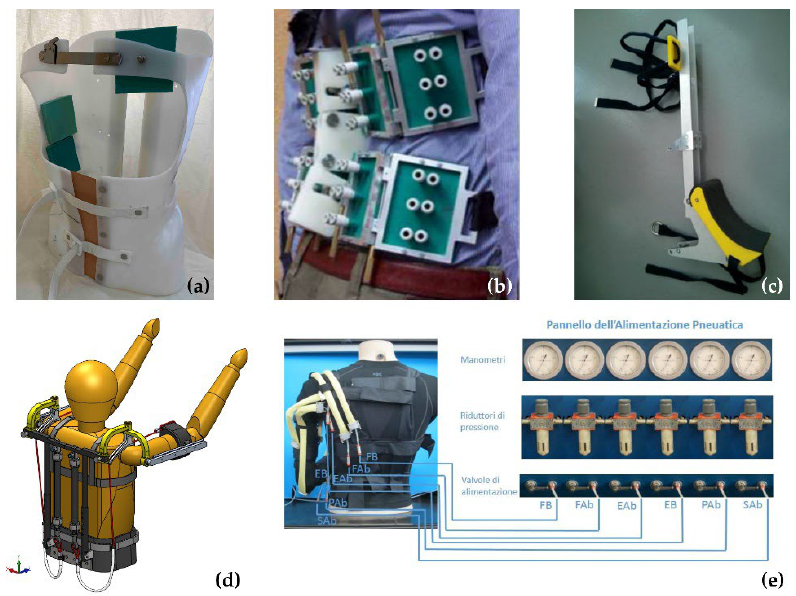
Figure 15. Rehabilitation and wearable device. ( a ) scoliosis brace [58]; ( b ) massage device [75]; ( c ) active exoskeleton for the back [77]; ( d ) passive exoskeleton for upper limbs [78,79]; ( e ) active suit for upper limbs [80].